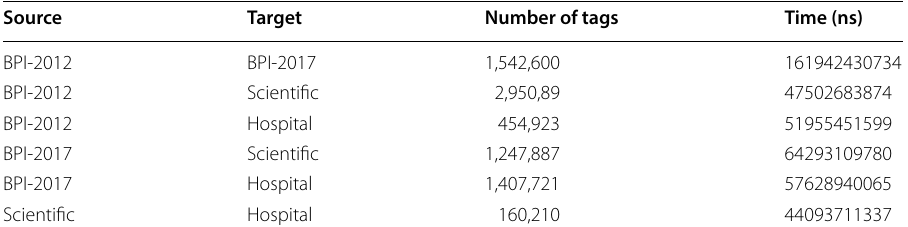
Table 1 CDCE on Big Data